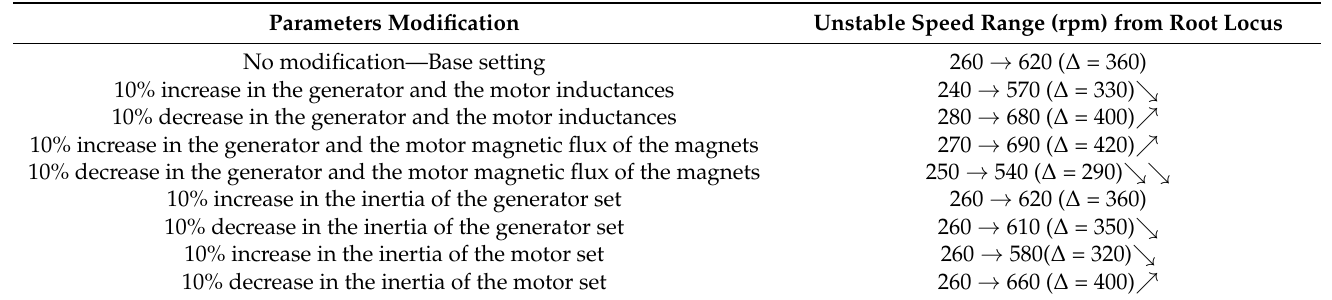
Table 4. Multi-parameter variations and associated results on the stability.